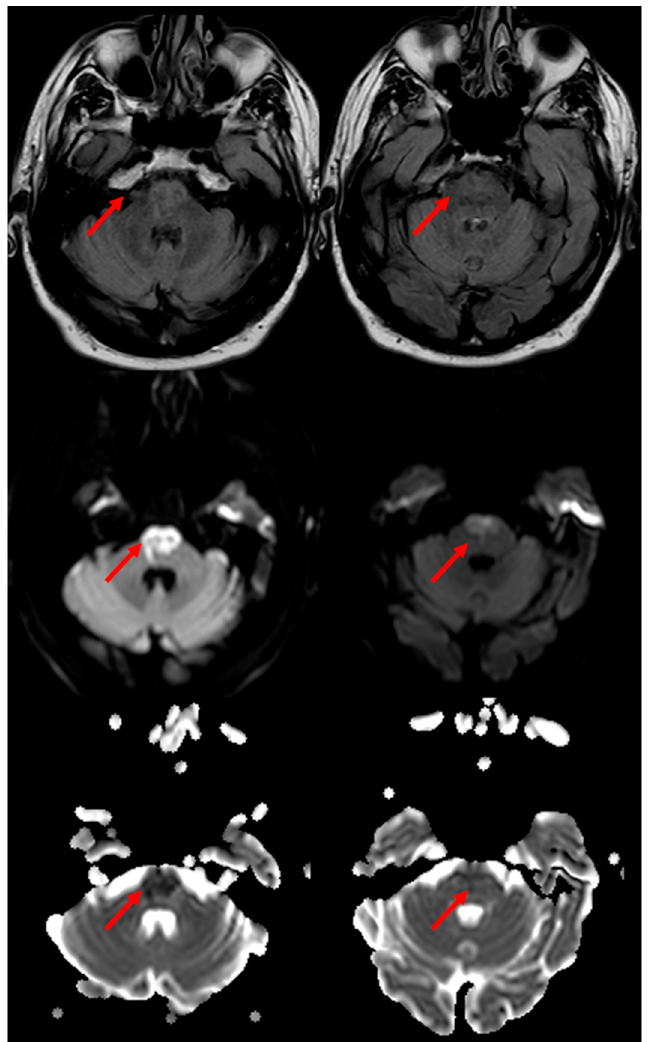
Figure 7. “Heart appearance sign” in acute bilateral pontine paramedian infarction, which is well evident in MRI on FLAIR axial images (first row), DWI images (second row) and Apparent Diffusion Coefficient (ADC) images (third row) (red arrows).